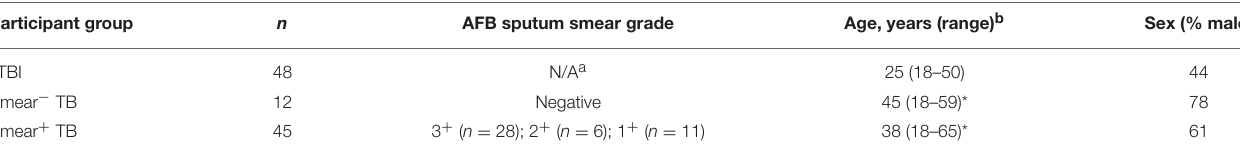
TABLE 1 | Characteristics of study population. Participant